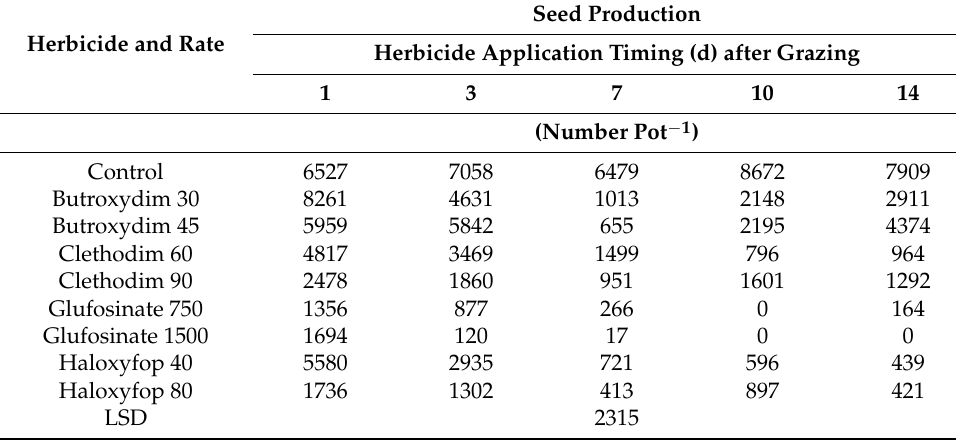
Table 6. The interaction effect of herbicide treatment and their application timing (1, 3, 7, 10, and 14 d after grazing) on the seed production (number pot − 1 ) of Chloris virgata